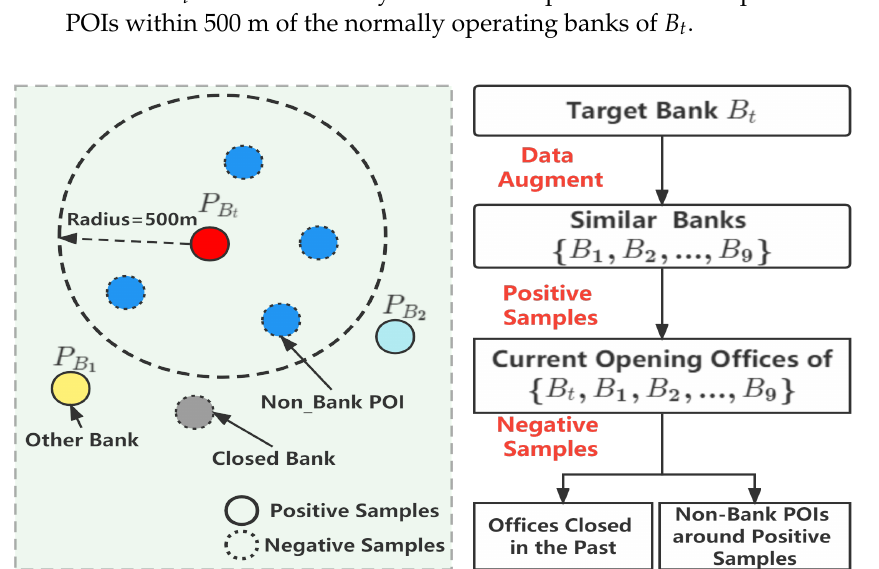
Figure 9. The process of building a bank recommendation